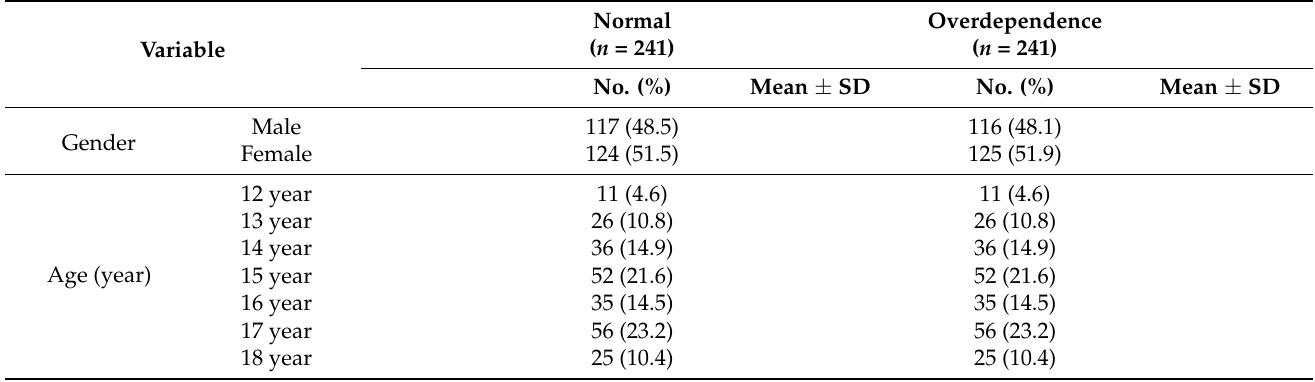
Table 1. Descriptive statistics for participants in the general and overdependence groups. ( n = 482).